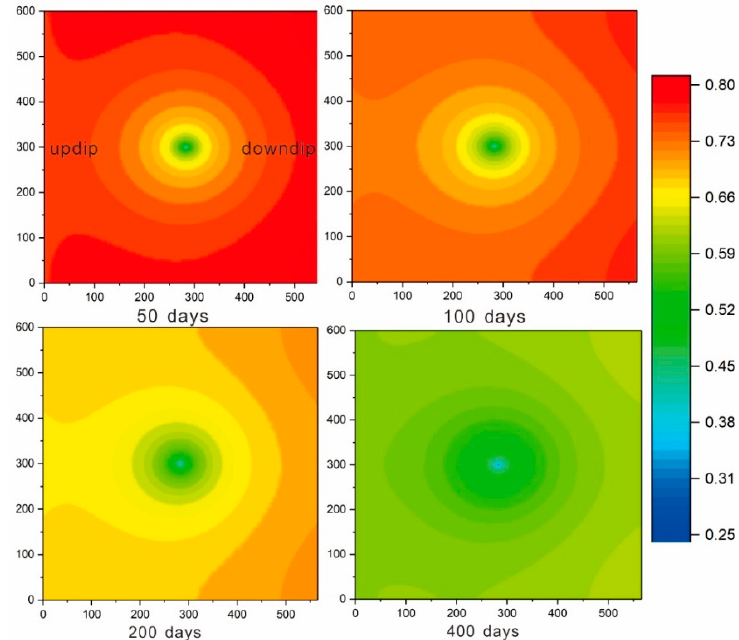
Figure 13. Nephogram of the water saturation distribution (vertical view).